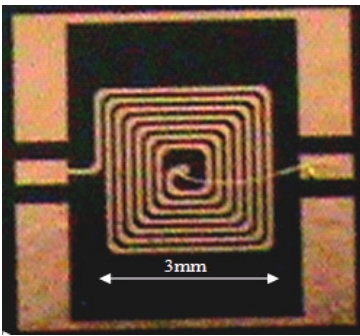
Figure 5: Photograph of the manufactured spiral inductor with its YIG